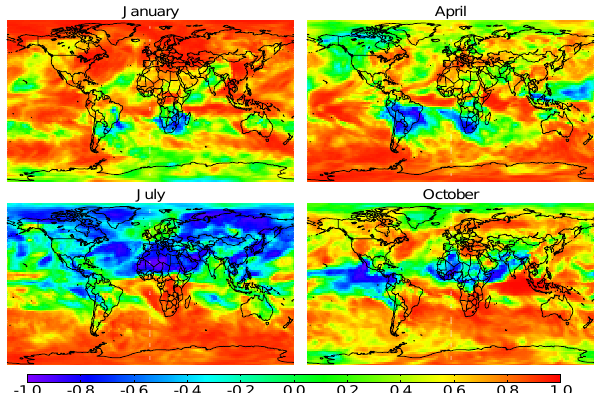
Fig. 5. Correlation coefficients between column CO 2 and column CO simulated by GEOS-Chem with GEOS-4 meteorology for 2006 at 2 ◦ × 2.5 ◦ resolution. Both CO 2 and CO are sampled at 13:30 local time. No averaging kernels are applied.